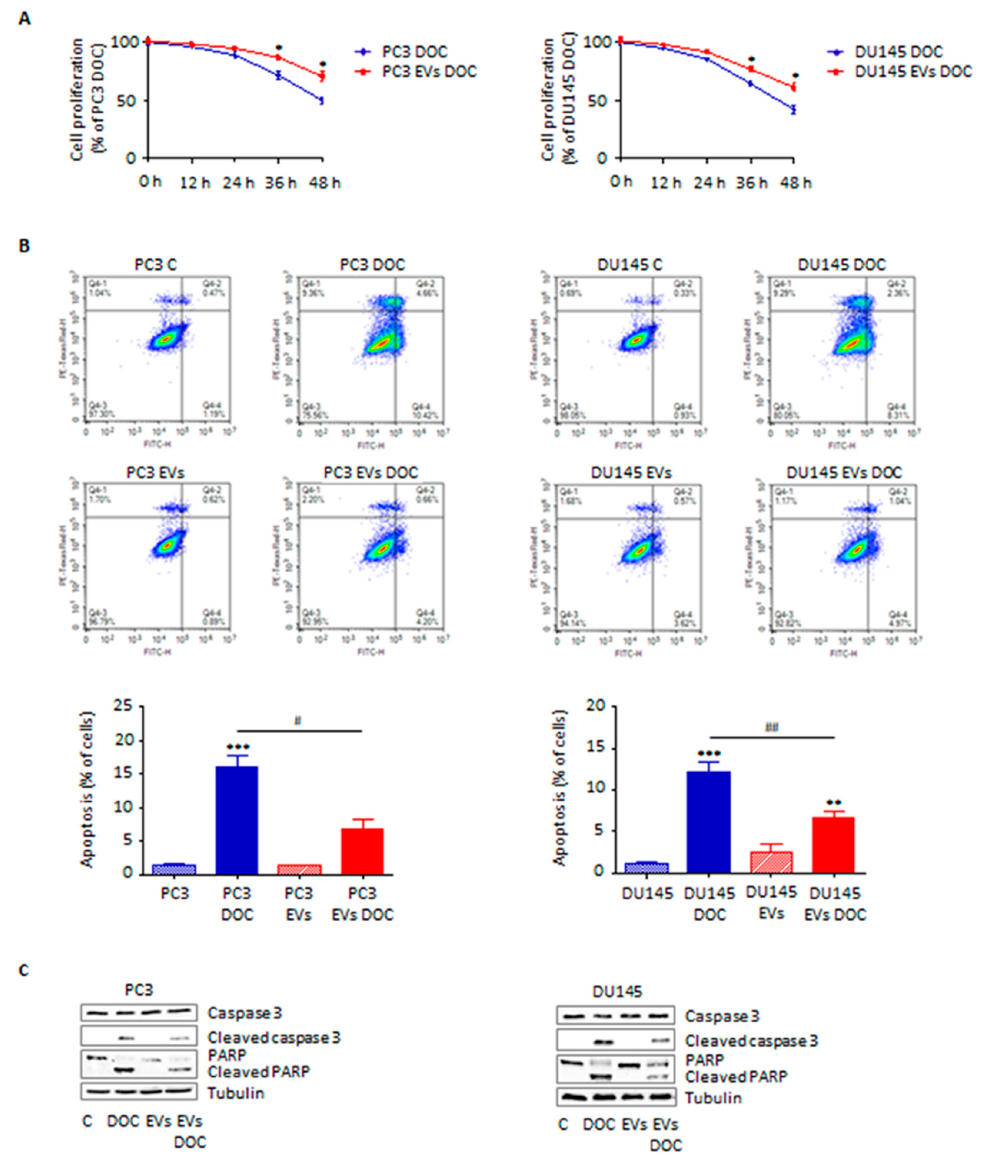
Figure 4. Adipocyte-secreted EVs enhance prostate cancer cell chemoresistance. ( A ) PC3 and DU145 cells were pre-treated with adipocyte-secreted EVs (30 μ g/mL) for 24 h and then treated with docetaxel (100 nM) for 48 h. Cell proliferation was then evaluated by Trypan Blue exclusion assay. Each experiment was repeated three times. Data represent mean values ± SEM and were analyzed using a t-test. * p < 0.05 vs. PC3 DOC or DU145 DOC (control). ( B ) Cells were pre-treated with adipocyte-secreted EVs (30 μ g/mL) for 24 h and then treated with docetaxel (100 nM) for 48 h. Apoptotic rate was then evaluated by cytofluorimetric analysis after staining with eBioscience™ Annexin V-FITC Apoptosis Detection Kit (according to the manufacturer’s protocol). One representative of three experiments performed is shown. Data represent mean values ± SEM and were analyzed using a Bonferroni's test after one-way analysis of variance. ** p < 0.01 vs. PC3 or DU145, *** p < 0.001 vs. PC3 or DU145, # p < 0.05 vs. PC3 DOC or DU145 DOC, ## p < 0.01 vs. PC3 DOC or DU145 DOC. ( C ) After adipocyte-secreted EV pre-treatment (30 μ g/mL, 24 h) and docetaxel treatment (100 nM, 48 h), Western blot analysis was performed to investigate the expression levels of cleaved caspase 3 and PARP. Tubulin expression was evaluated as a loading control. One representative of three experiments performed is shown.